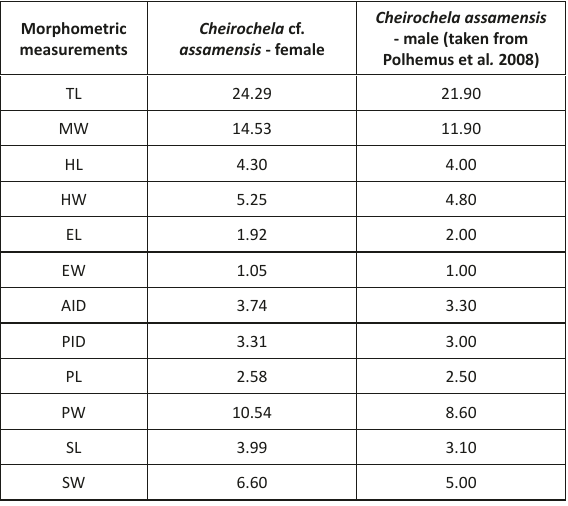
Table 1. Morphometric comparison of male and female specimens of C. assamensis (all measurements in